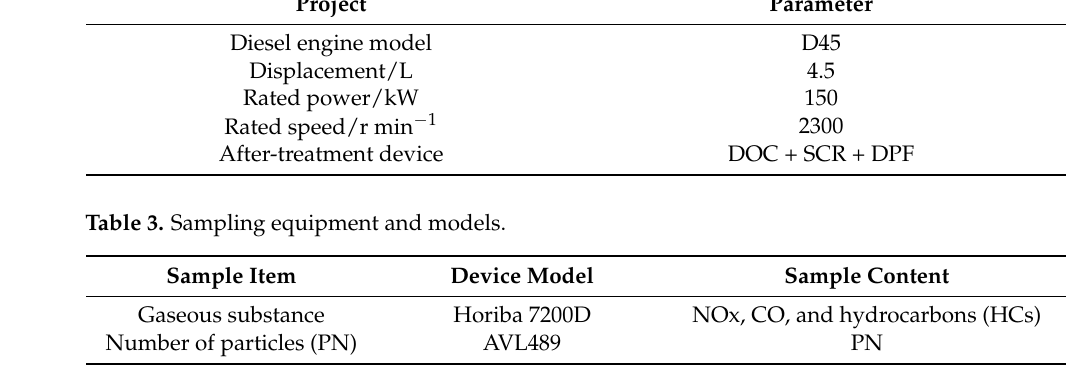
Table 2. Parameters of the diesel engine.